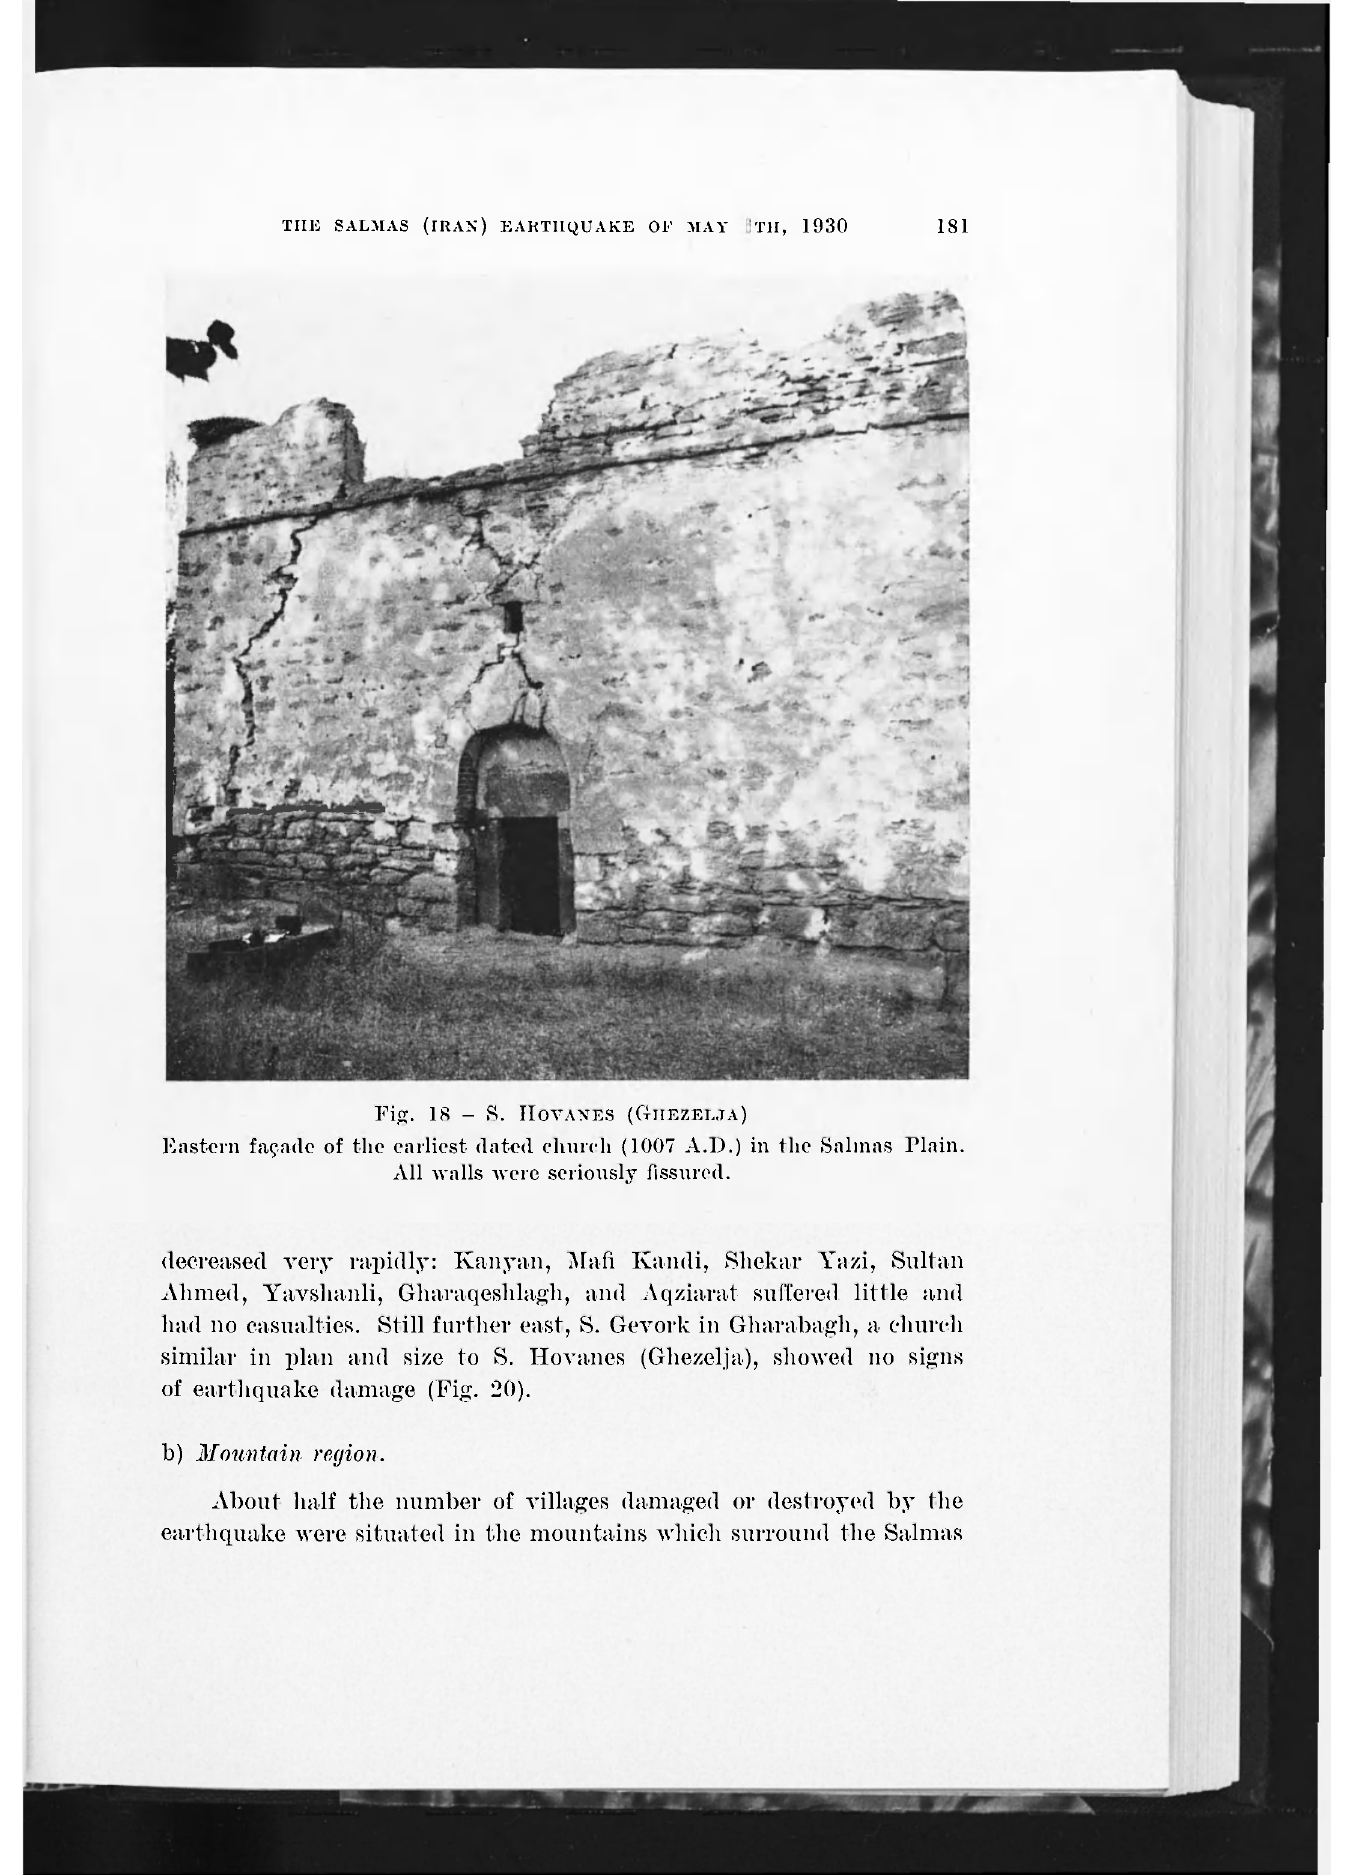
Fig. 18 - S. HOVANES (G-HEZELJA) Eastern façade of the earliest dated church (1007 A.D.) in the Salinas Plain. All walls were seriously